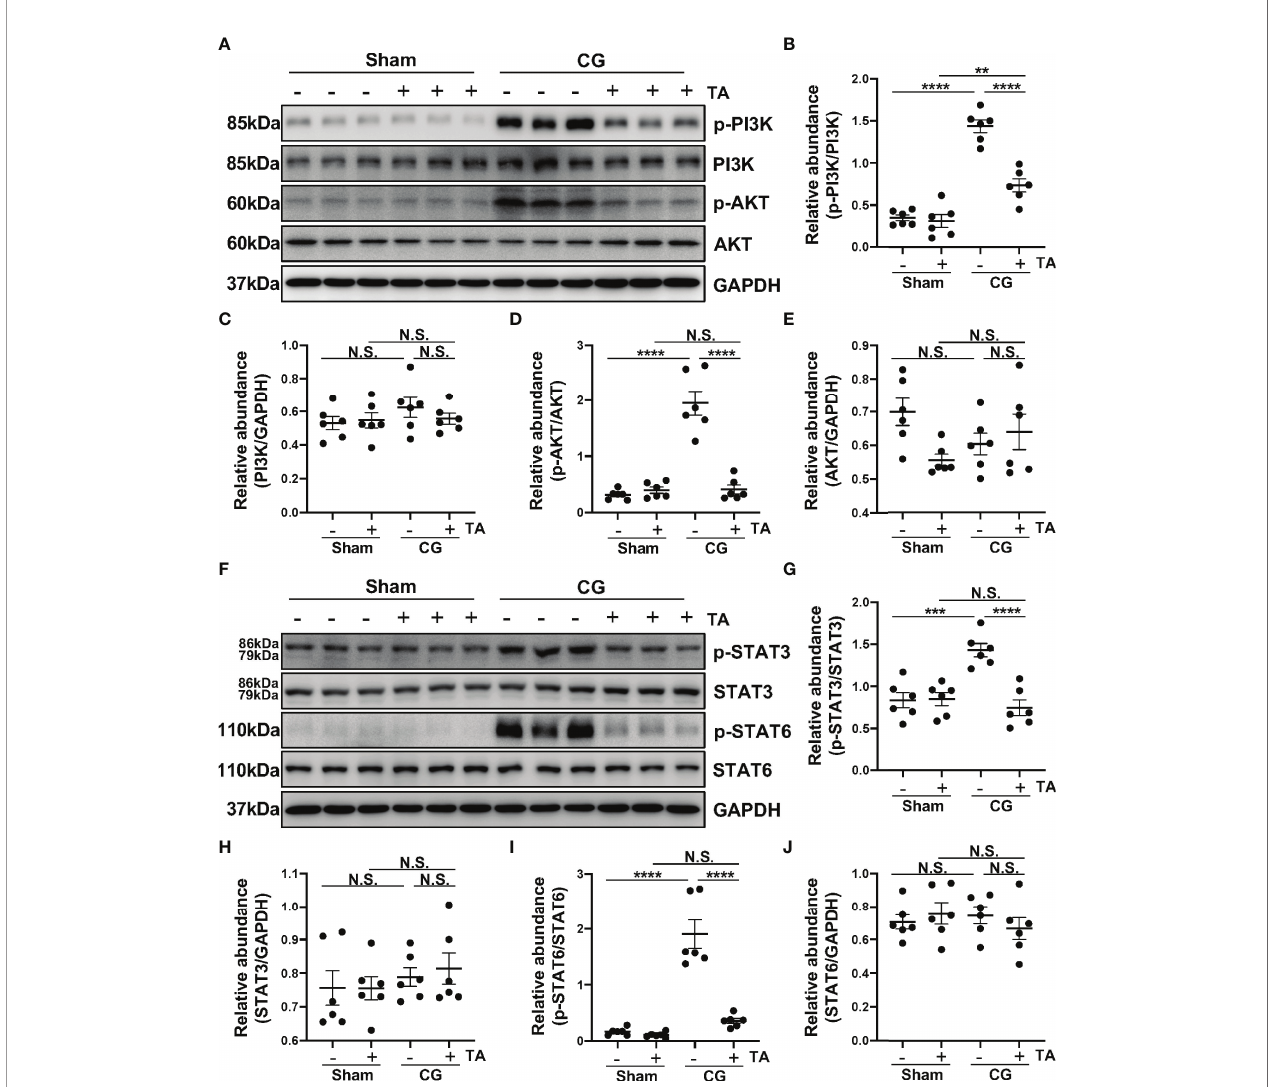
FIGURE 5 | Inhibition of HDAC6 by TA prevents M2 macrophage polarization via suppressing PI3K/AKT, STAT3 and STAT6 signaling in vivo . (A) Western blot analysis showed the levels of p-PI3K, PI3K, p-AKT, AKT and GAPDH in peritoneum from different groups of mice. Expression levels of (B) p-PI3K, (C) PI3K, (D) p- AKT, and (E) AKT in different groups were quanti fi ed by densitometry and normalized with GAPDH, PI3K, AKT respectively. (F) Western blot analysis showed the levels of p-STAT3, STAT3, p-STAT6, STAT6, and GAPDH in peritoneum from different groups of mice. Expression levels of (G) p-STAT3, (H) STAT3, (I) p-STAT6, and (J) STAT6 in different groups were quanti fi ed by densitometry and normalized with GAPDH, STAT3, and STAT6 respectively. Data were expressed as means ± SEM. **P<0.01, ***P<0.001, ****P<0.0001. NS: P ≥